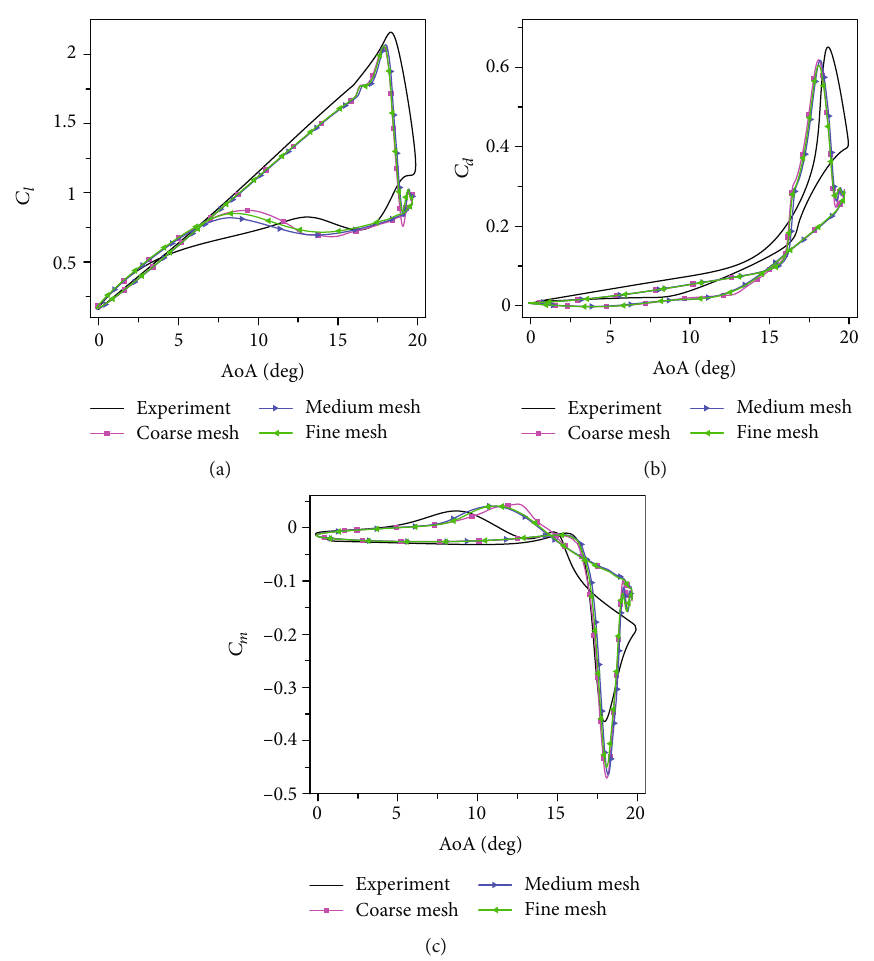
Figure 8: Comparison of aerodynamic coe ffi cients between calculation and experiment: (a) lift coe ffi cients, (b) drag coe ffi cients, and (c) pitching moment coe ffi